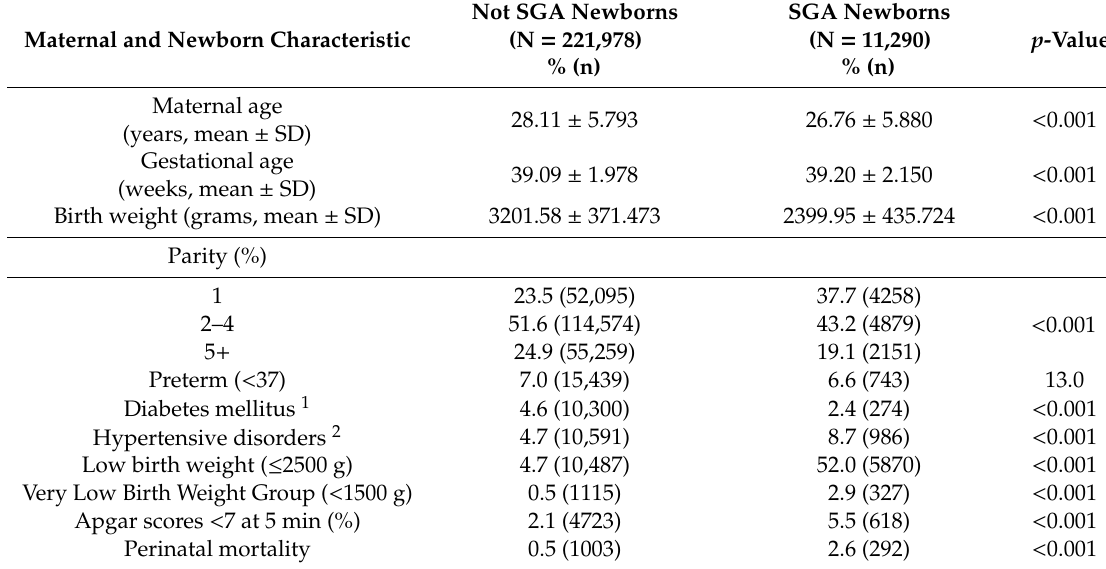
Table 1. Maternal characteristics and delivery outcomes based on study